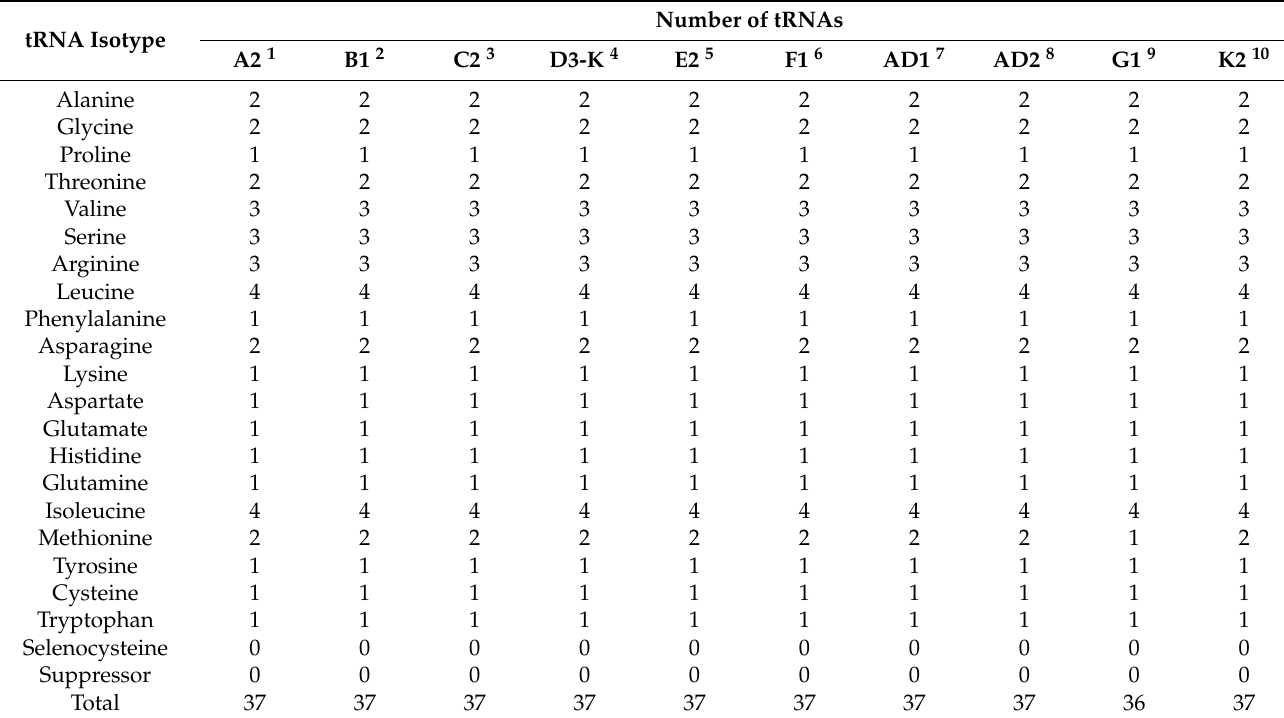
Table 2. Distribution of tRNA isotypes in cotton chloroplast